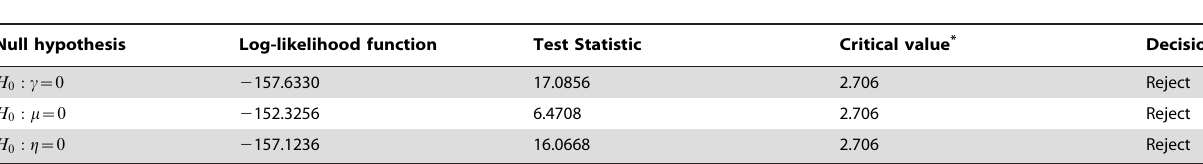
Table 7. Generalized Likelihood-Ratio Test of Hypothesis of the Stochastic Frontier Production